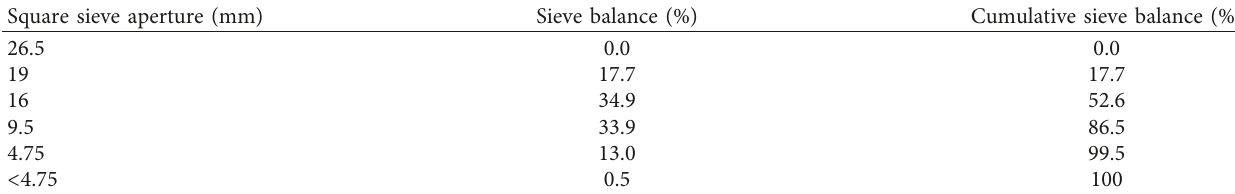
Table 4: Screening results of the coarse aggregates.